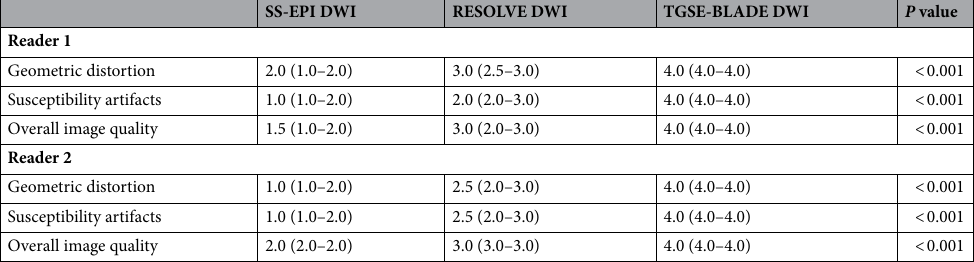
Table 4. Results of image quality for SS-EPI DWI, RESOLVE DWI, and TGSE-BLADE DWI in patients who underwent cerebral aneurysm clipping. Data are presented as the median (interquartile range) score. a SS-EPI DWI versus RESOLVE DWI; b RESOLVE DWI versus TGSE-BLADE DWI; c SS-EPI DWI versus TGSE-BLADE DWI.